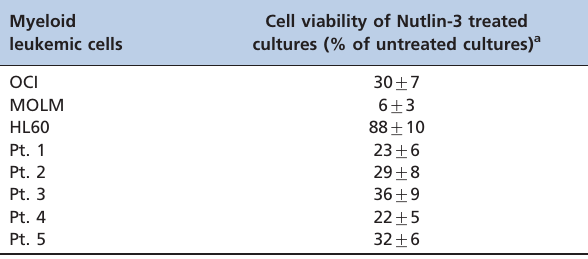
Table 1 - Effect of Nutlin-3 treatment on myeloid leukemic cell